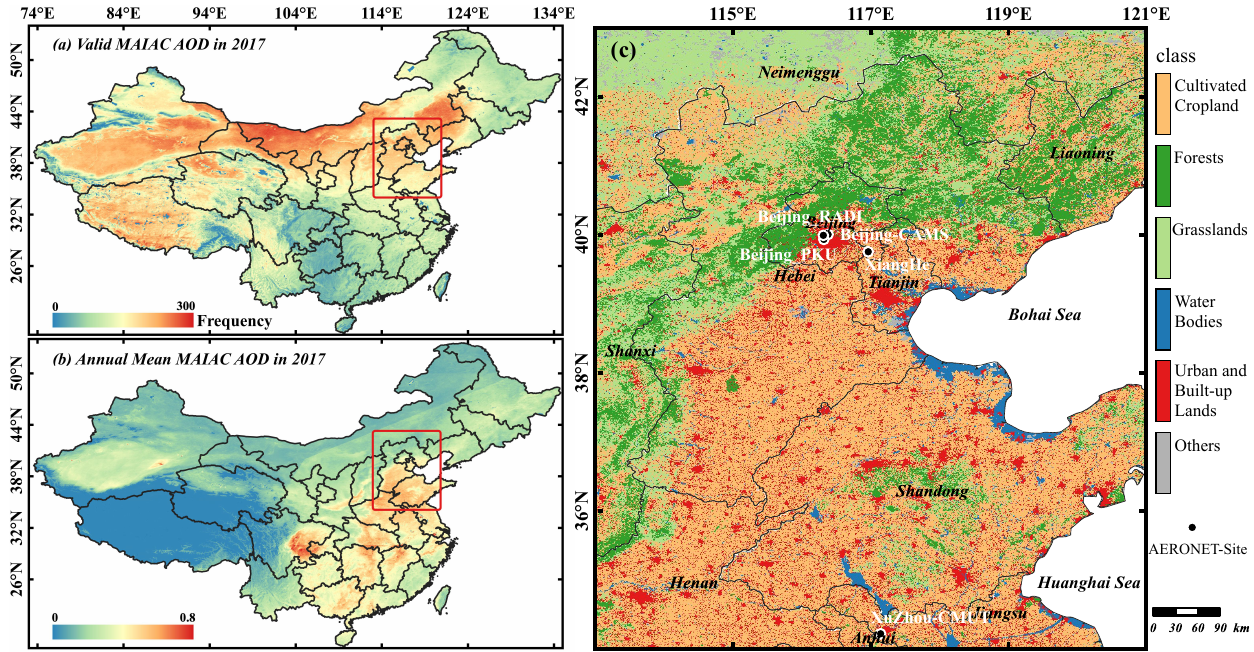
Figure 3. ( a ) The frequency of valid MAIAC AOD (470 nm) observation in 2017; ( b ) the annual mean MAIAC AOD (470 nm) observation in 2017. The red rectangular area is the study area; ( c ) the land cover of the study area. The five overlaid dots represent the AERONET